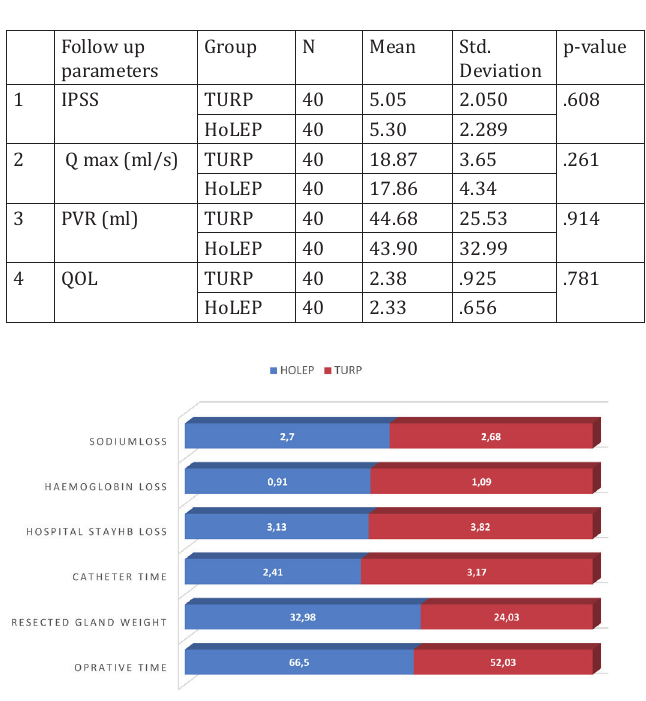
Comparision of follow up parameters at 3 months in Both study groups